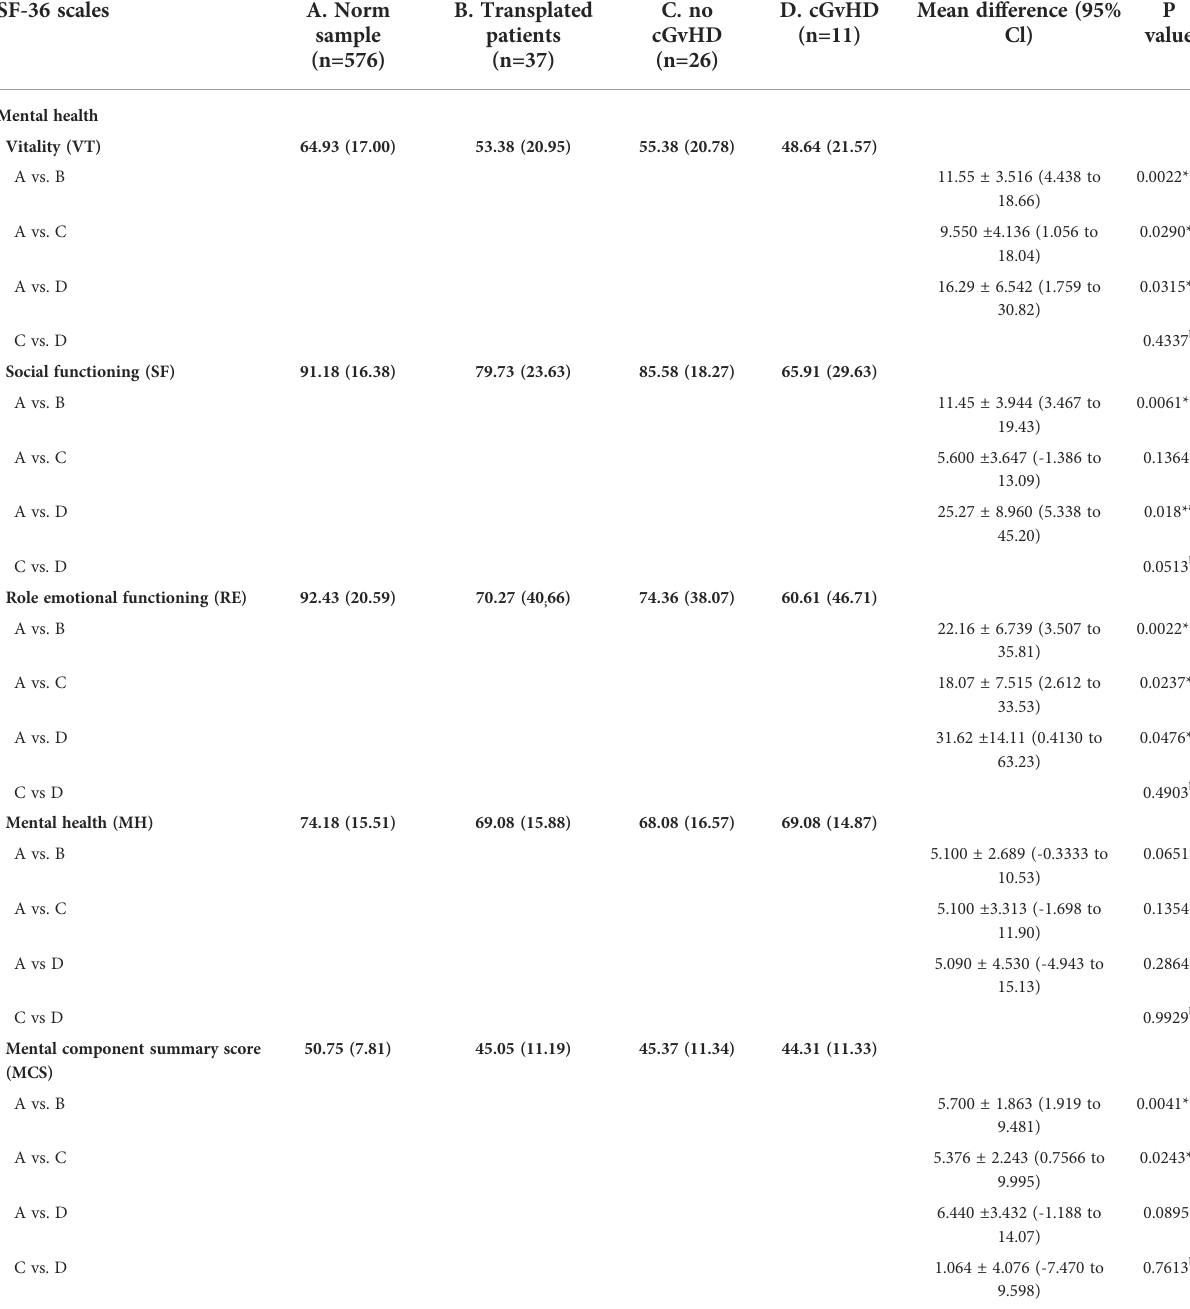
TABLE 2 Mental health as scored by the SF-36 questionnaire and level of signi fi cant differences in participants with and without GvHD. and in comparison to the norm sample. SF-36